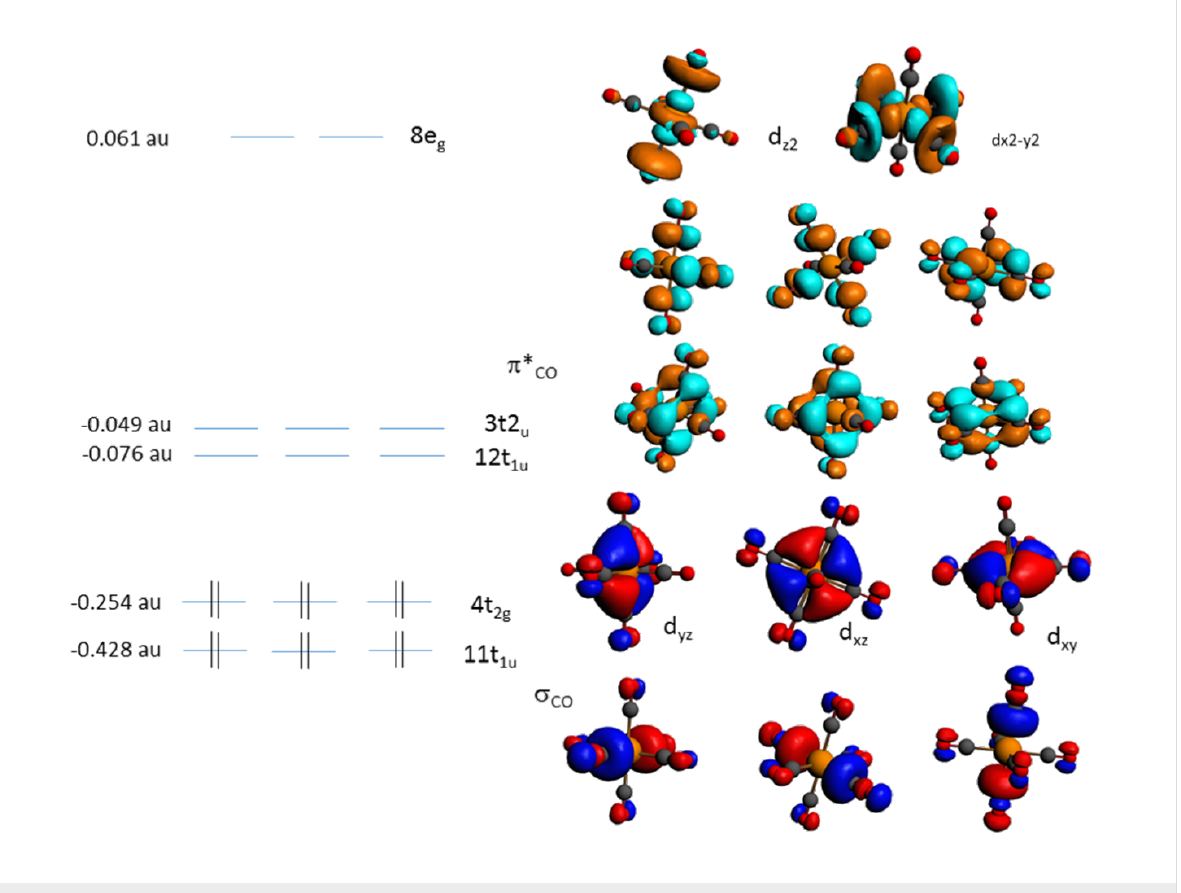
Figure 2: Valence Kohn–Sham orbitals of W(CO) 6 in its electronic ground